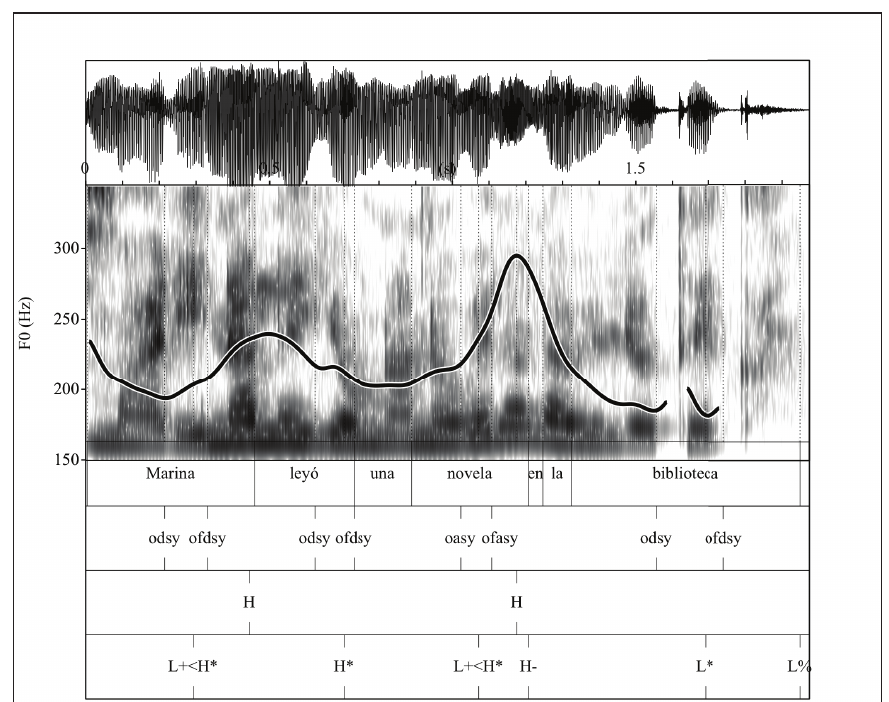
Figure 9: The utterance Marina ley ó una novela en la biblioteca ‘Marina read a novel in the library’ as produced by participant